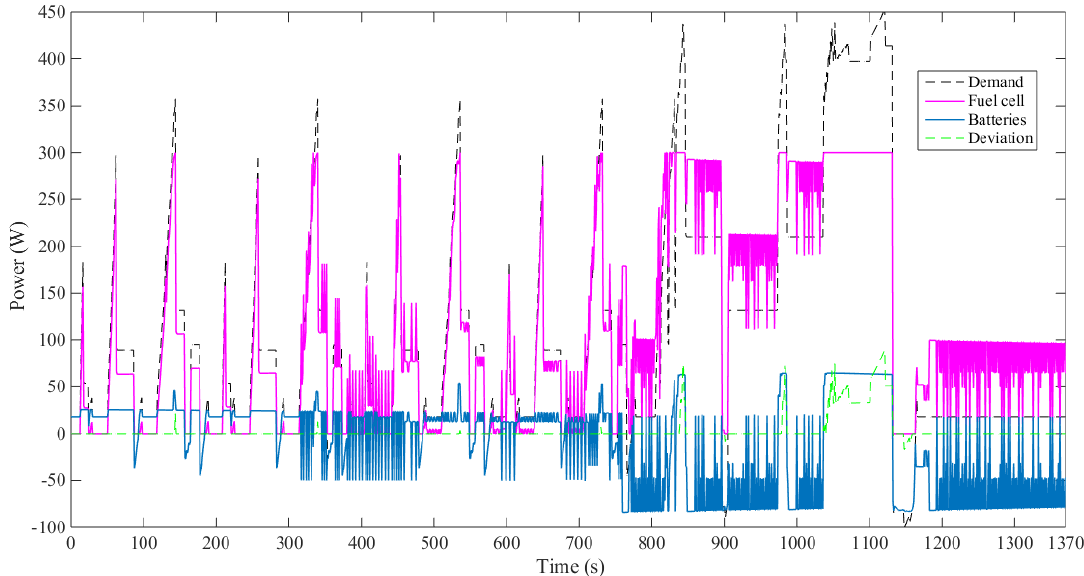
Figure 14. The power demand and the output power of each energy source.